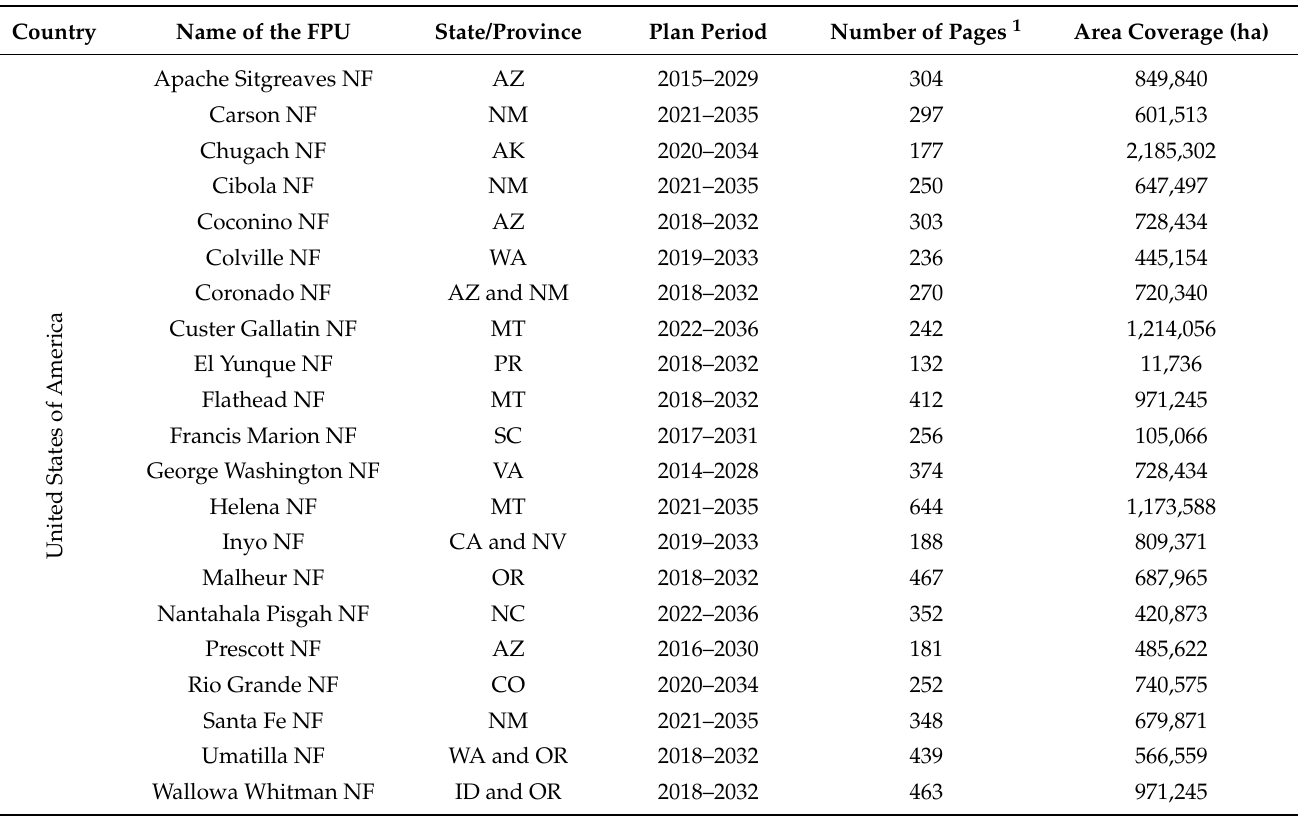
Table 1. Specification of the forest planning units (FPUs), including the name, location, area coverage, plan period, and plan length (national forest: NF, forest management chiefdom: